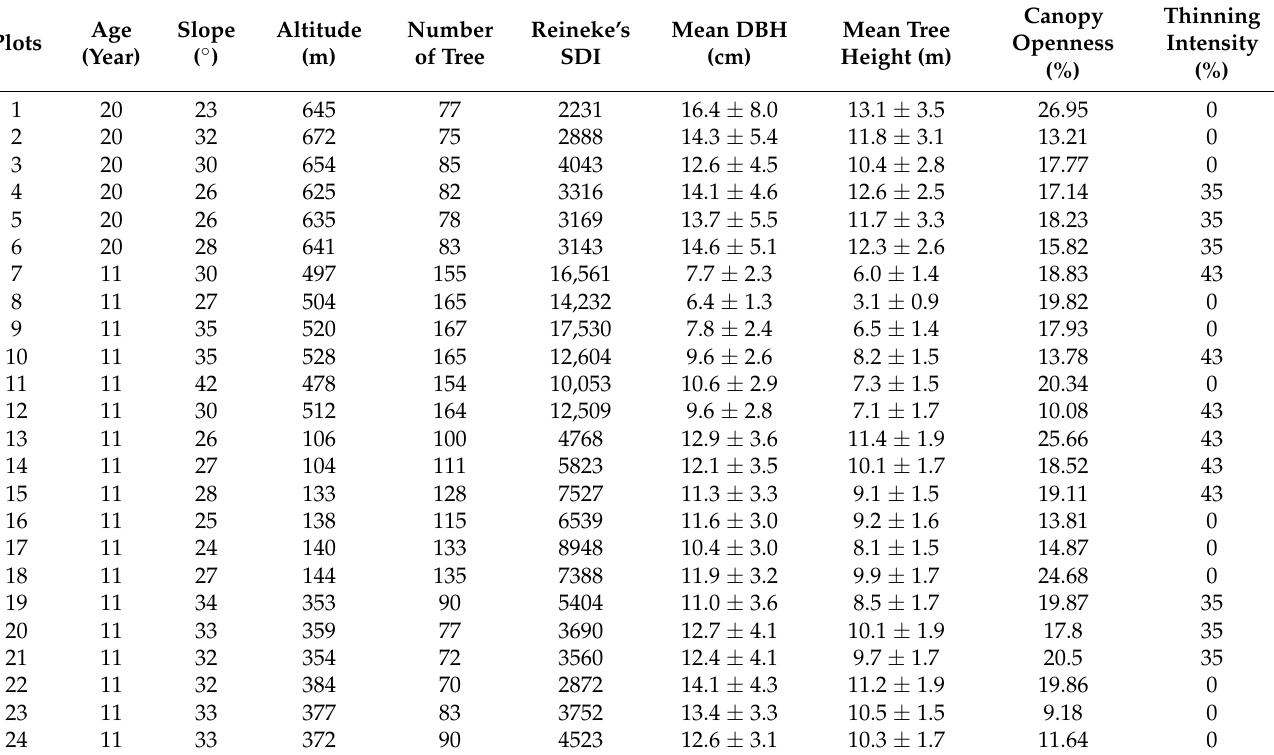
Table 1. Basic information of the study